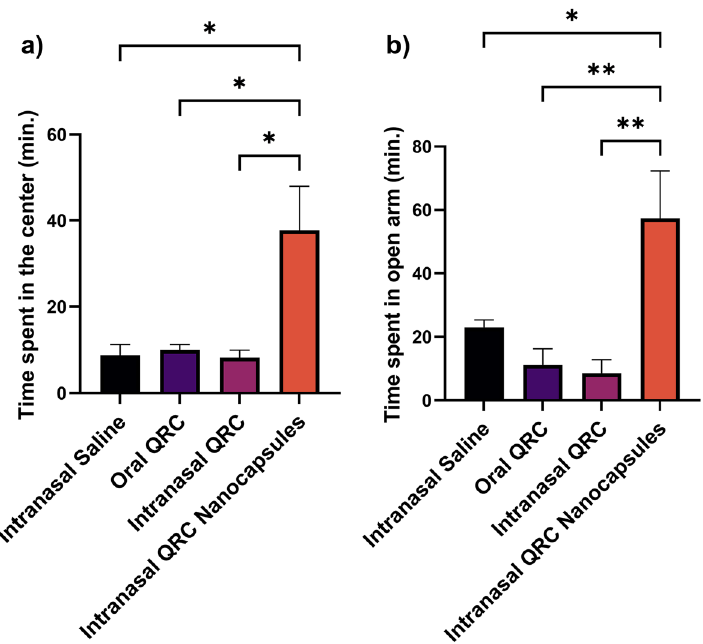
Figure 6. In vivo results of ( a ) time spent in the center of the open field, and ( b ) time spent in the open arm of the elevated plus-maze. The vertical bars represent mean ± Standard Error of Mean (SEM) where values are statistically significant at P < 0.05. *P < 0.05, **P <